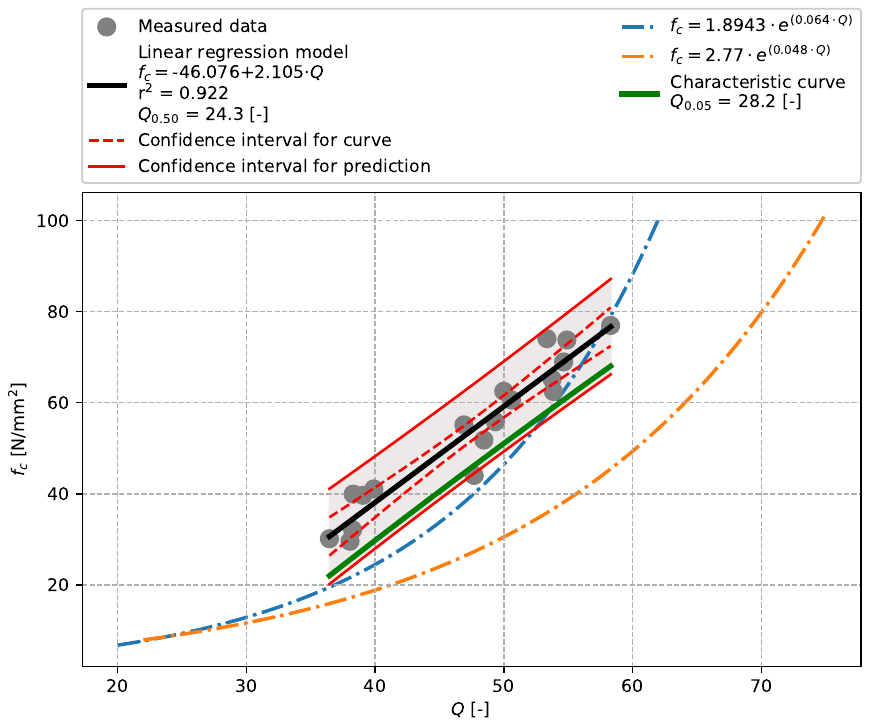
Figure 6. Bridge concrete described in Section 3.1—model of the dependence of the Q -value [-] vs. compressive strength f c [N/mm 2 ]—SilverSchmidt